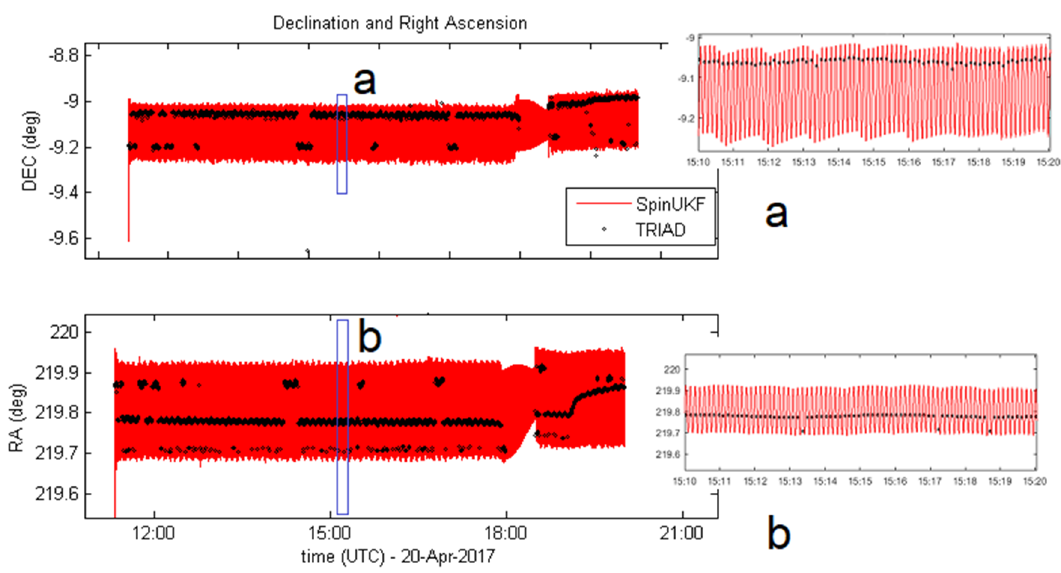
Figure 10. Fine spin-axis estimation by the SpinUKF and TRIAD on 20 April 2017 from 11:00 to 20:00 UTC. Both algorithms use SSC and SSAS measurements. Subfigures a and b zoom to the shown parts on main figure.